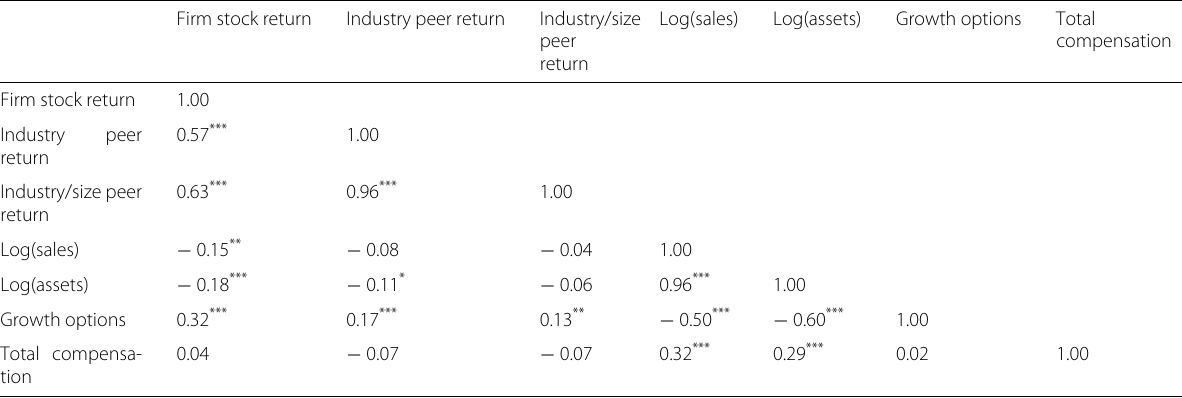
Table 16 Pearson correlation coefficients without the years 2007 and